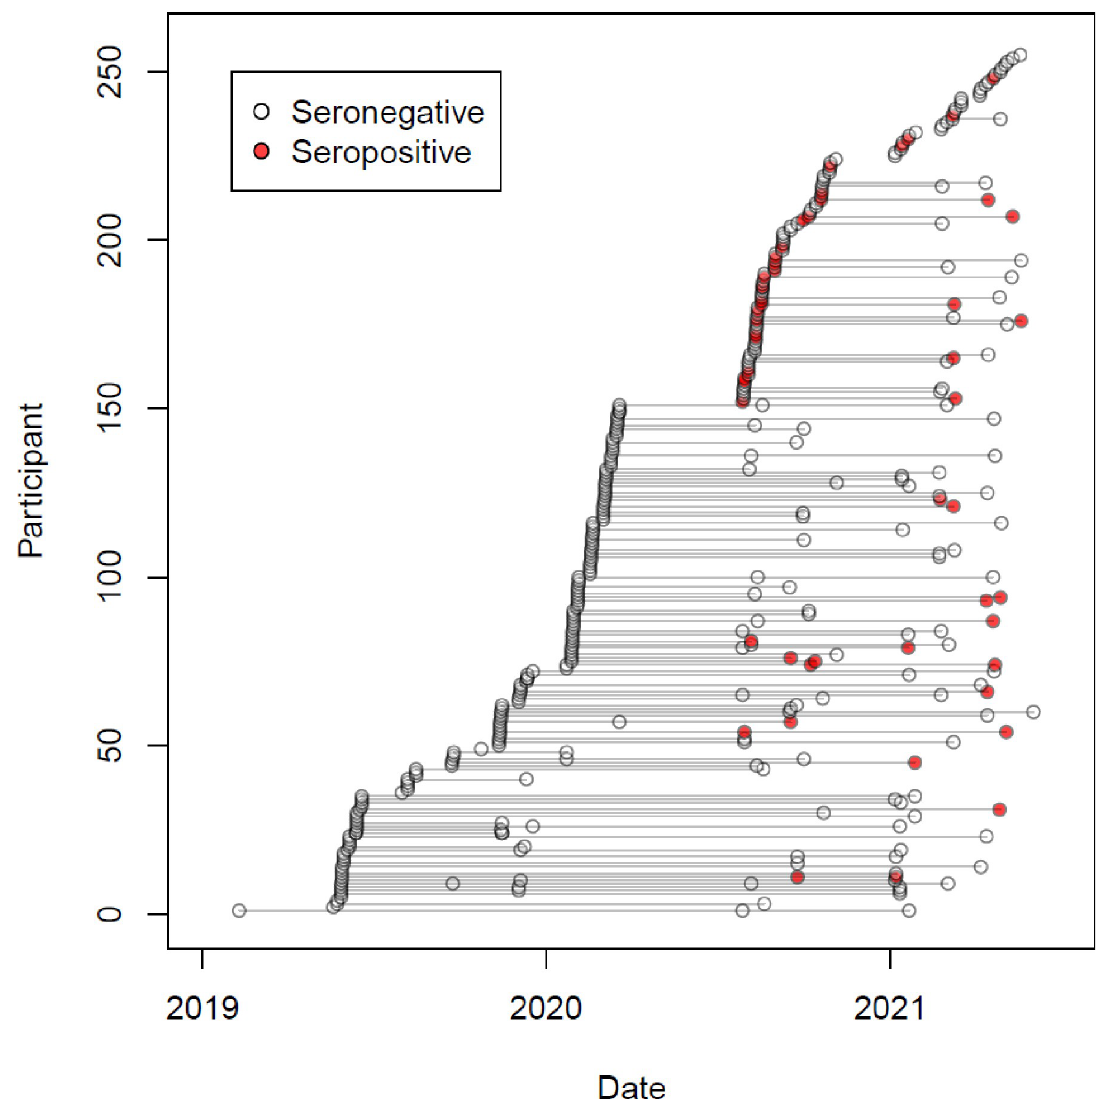
Fig 2. Times of follow up for each infant with serostatus indicated from 2019 to 2021. Seropositive samples are shown in red and the seronegative are without fill. Lines connect samples from the same infant. time in our study population. Hazards estimated for intervals before and after March 1, 2020 13 � 1, 2.8e7). Age of child, mother’s age, educational attainment, marital status, urban/rural sta-